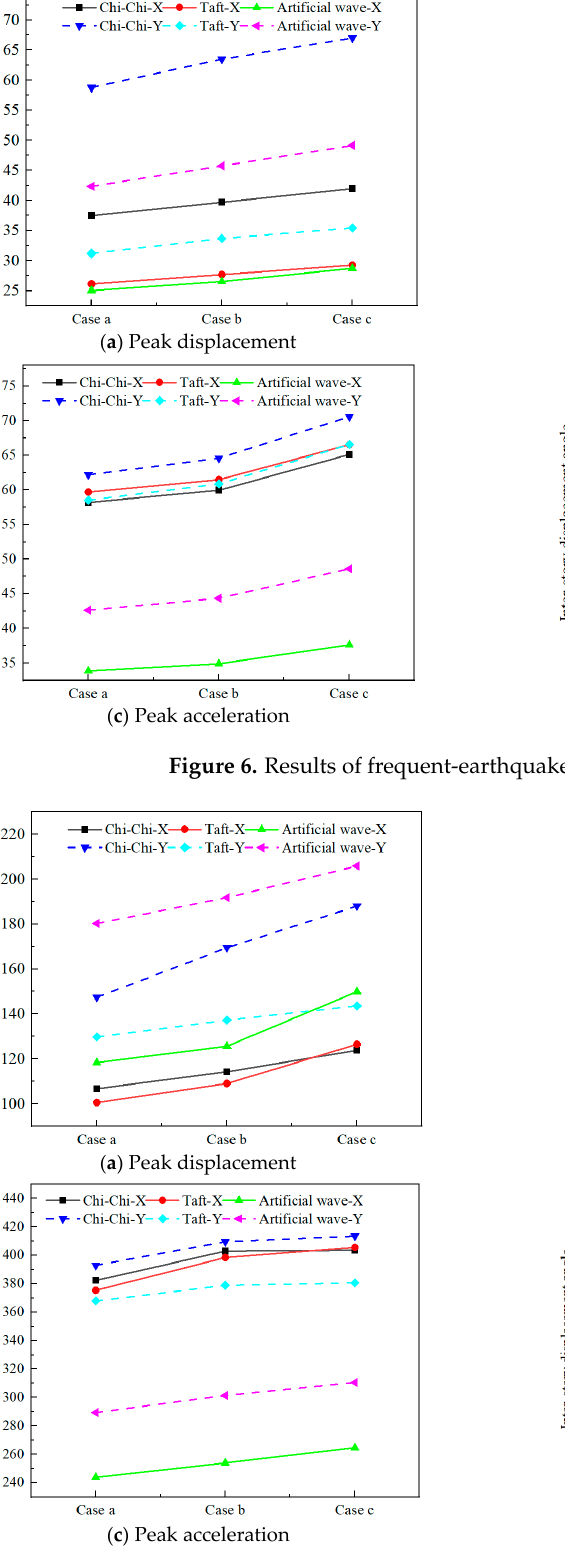
Figure 7. Results of rare-earthquake time-history